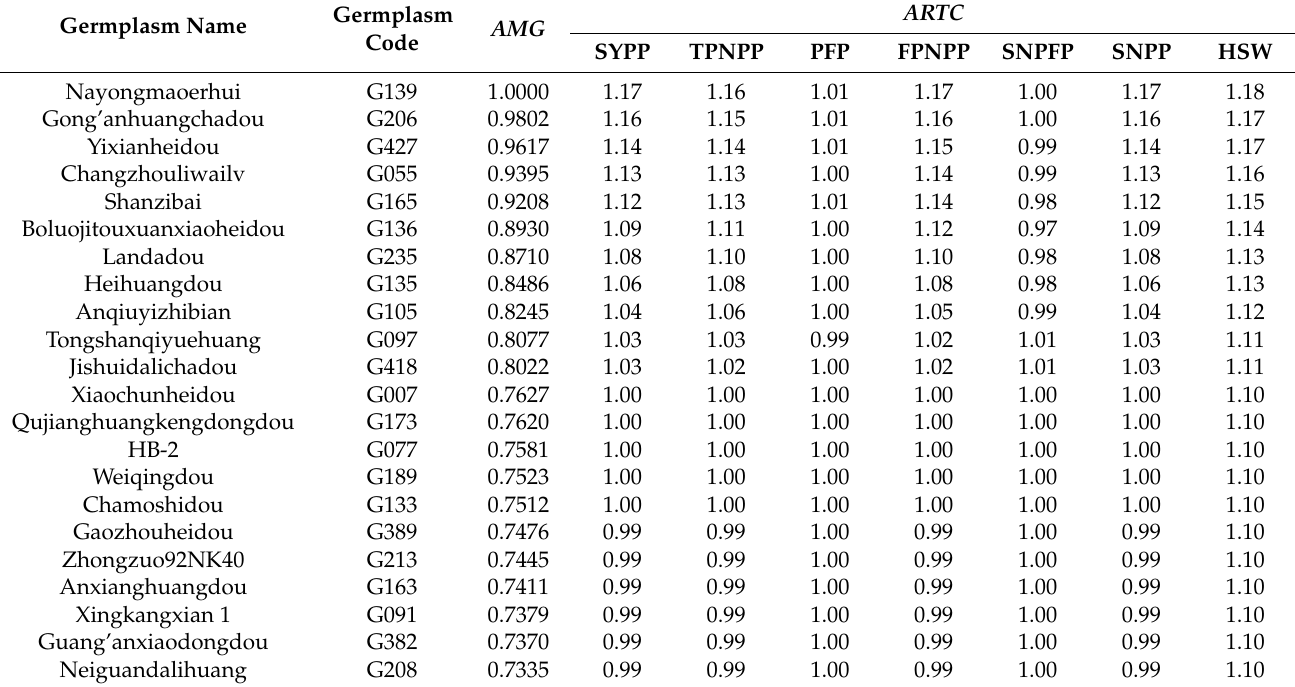
Table 7. ARTC s of seed yield and yield components for highly AR-tolerant soybean germplasms screened using the multiple traits comprehensive evaluation